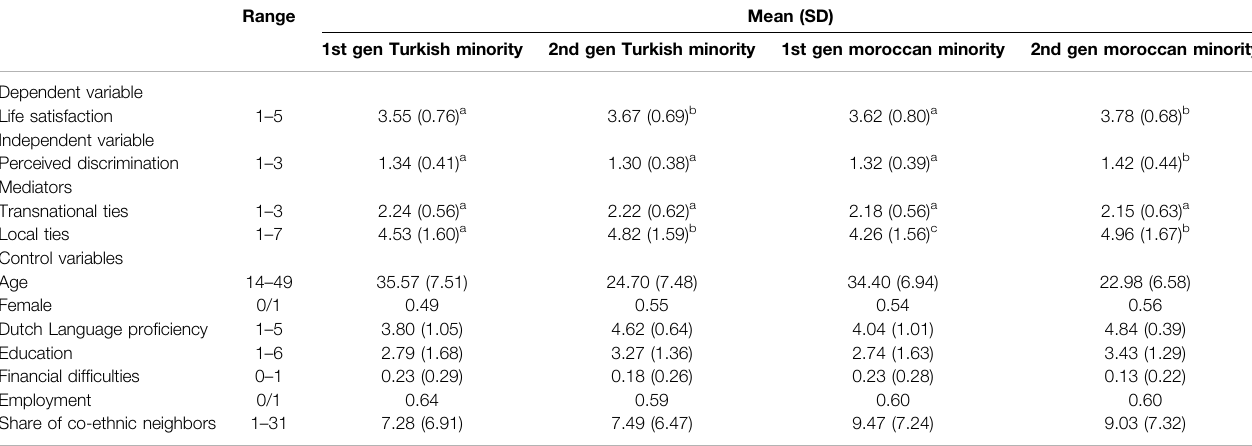
TABLE 4 | Descriptive statistics of all variables in the analyses [1 st generation Turkish minority ( n (cid:1) 646), 2 nd generation Turkish minority ( n (cid:1) 358), 1 st generation Moroccan minority ( n (cid:1) 638), 2 nd generation Moroccan minority ( n (cid:1) 370)].